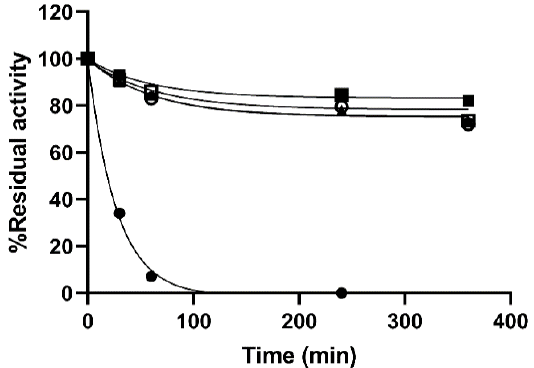
Figure 3. Thermal stability of β‐ Glc preparations at 75 °C. Soluble β‐ Glc (full circles), β‐ Glc entrapped